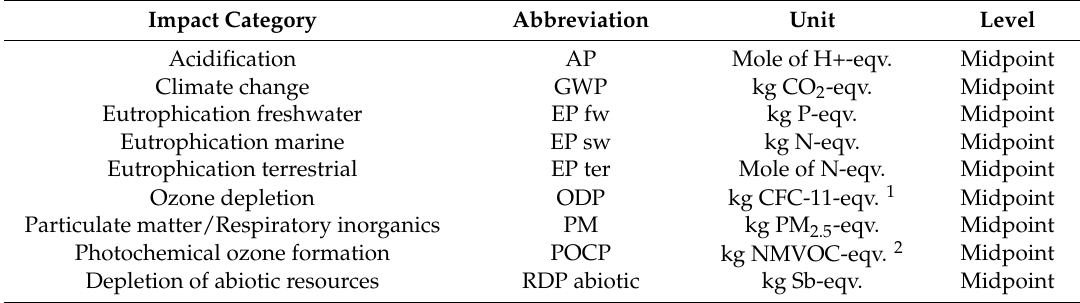
Table 2. Overview of investigated ILCD impact categories (based on